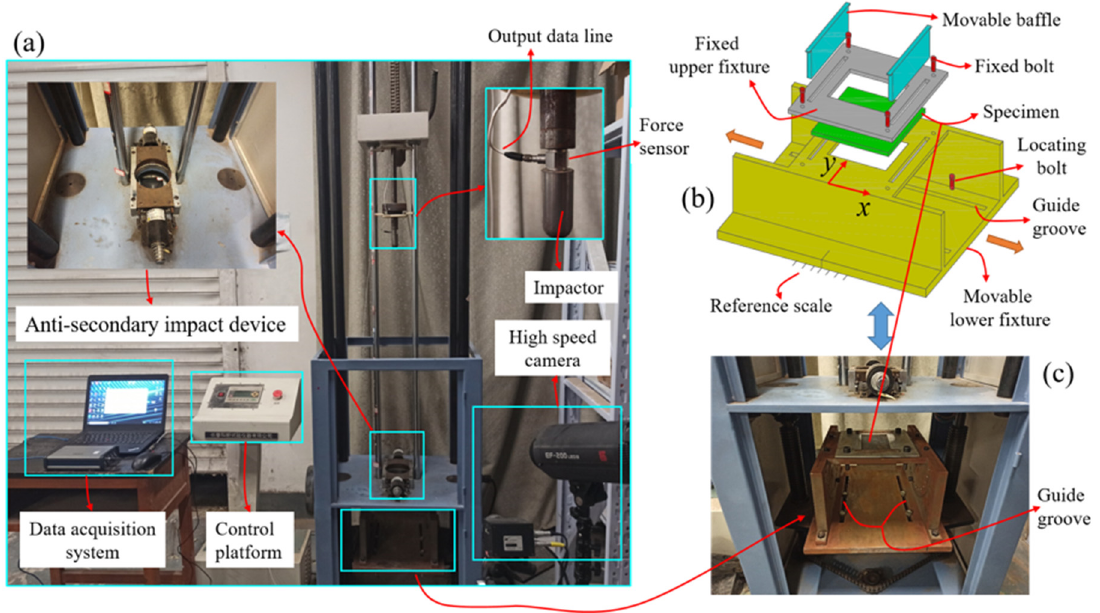
Figure 2. Dropweight impact test platform: ( a ) XBL-300 drop weight impact test machine, ( b ) im- proved specimen fixture and ( c ) photograph of improved specimen fixture.